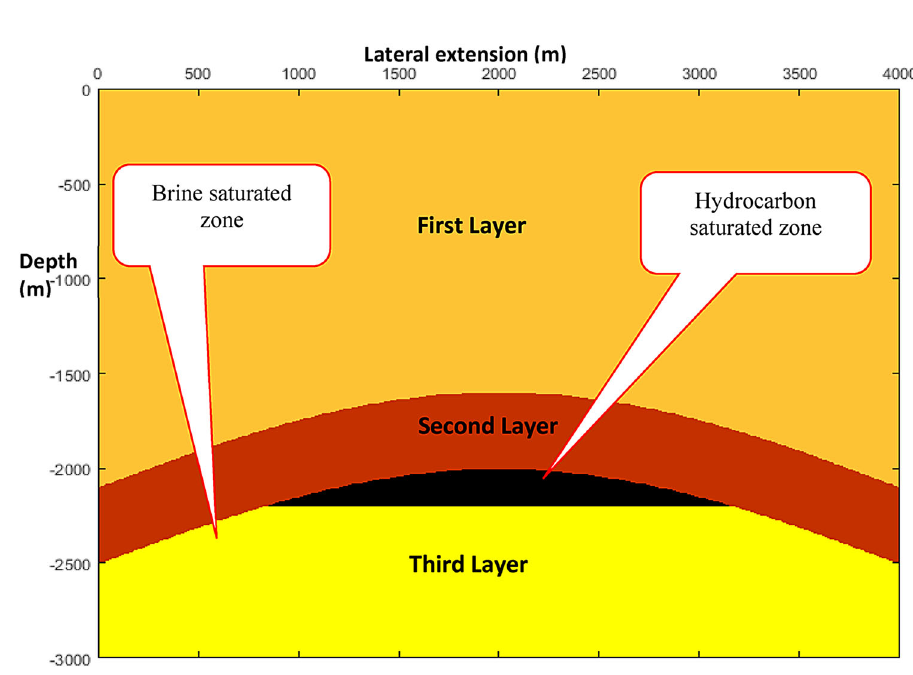
Fig. 2 Geological